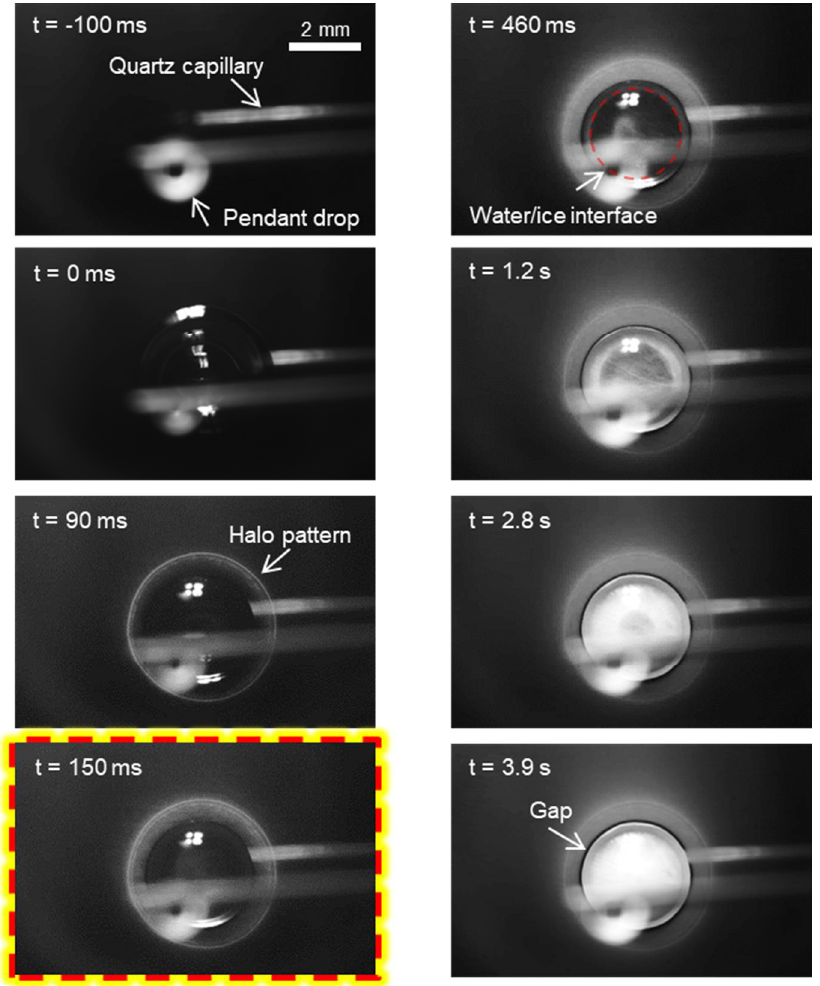
Figure 2. Freezing dynamics of the impinging drop at the substrate temperature of T s = −15.4 ± 0.2 °C, i.e., regime I: spread-recoil-freeze. The highlighted capture denotes the onset of icing nuclea- tion.